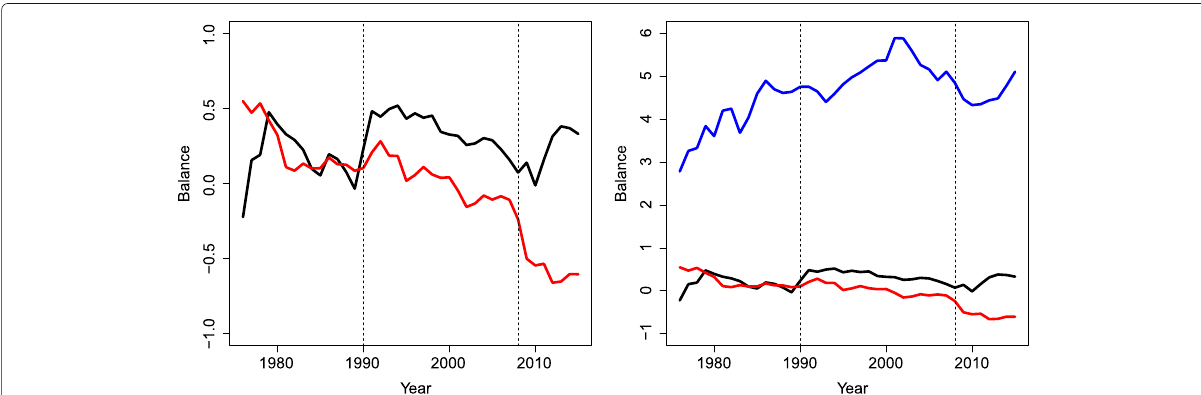
Fig. 11 (left) Evolution of the balances corresponding to the three big ports following the selected SBP (Eq. 11). First balance b 1 (black line); second balance b 2 (red line). (right) Evolution of three selected balances of the SpanishMed ports following the selected SBP (Table 5). The blue line shows the evolution of the balance that compares the three big ports with the rest of the non-insular ports ( b 2 ; Eq. 10). Black and red lines represent the balances between the three big ports, according to the selected SBP ( b 3 and b 4 ). Note that the compositional treatment of the shares ensures subcompositional coherence. Black and red lines are the same in left and right figures. Vertical lines show the limits of the three periods